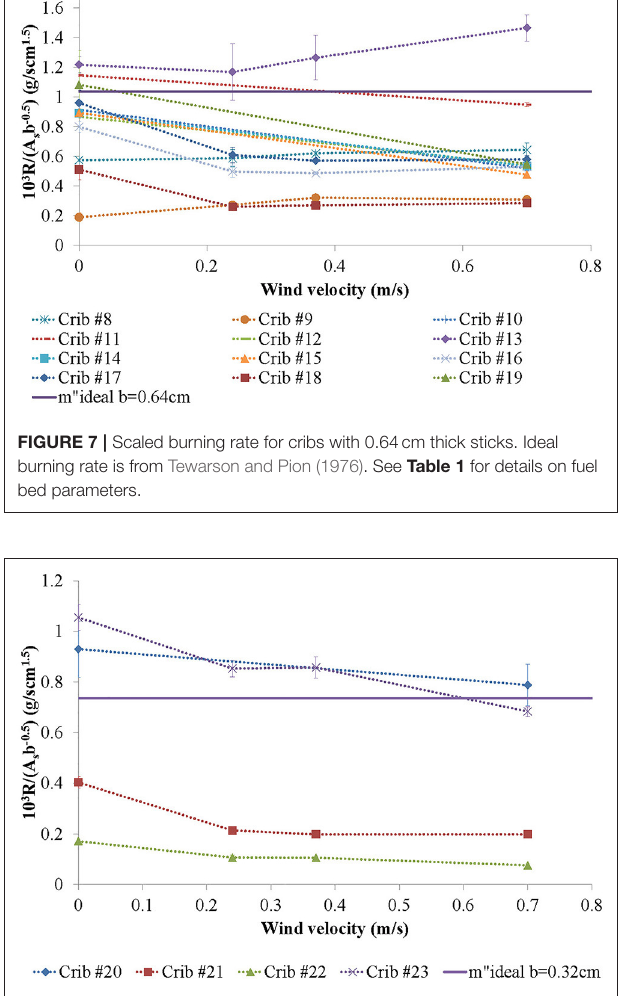
FIGURE 8 | Scaled burning rate for cribs with 0.32cm thick sticks. Ideal burning rate is from Tewarson and Pion (1976). See Table 1 for details on fuel bed parameters.